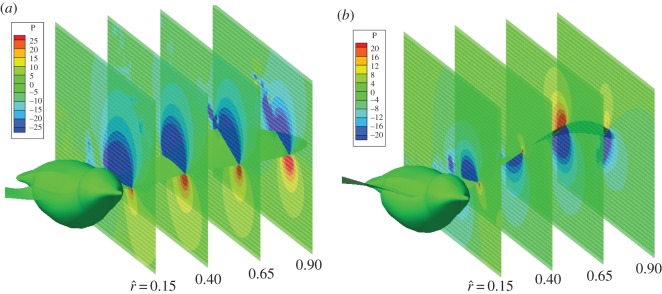
Pressure distribution (in Pascals) in the parasagittal planes at (a) mid-downstroke and (b) mid-upstroke.